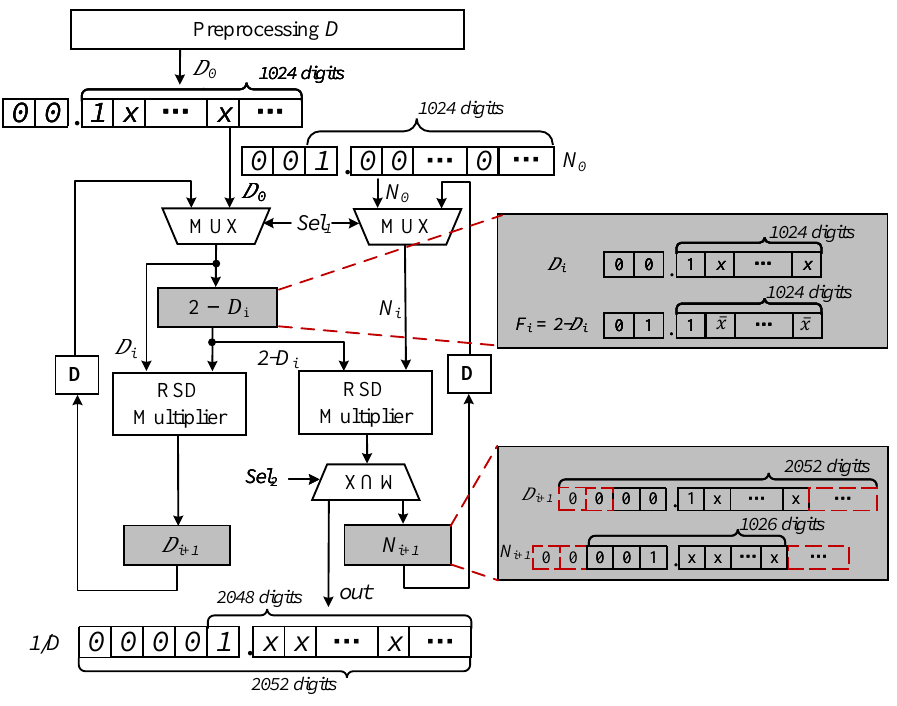
Figure 5: The architecture for calculating the reciprocal using Goldschmidt algorithm. During the iteration, F i = 2 − D i is first computed by simple logical operations. Then, D i +1 = D i ∗ F i and N i +1 = N i ∗ F i are computed by RSD multipliers in parallel.